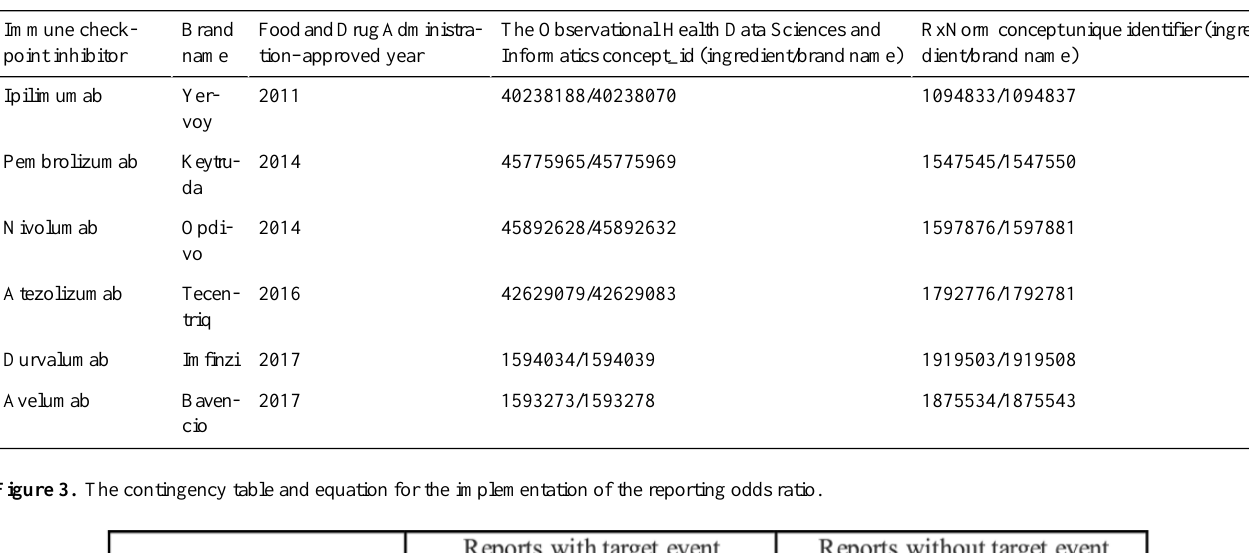
Table 1. The basic information of 6 immune checkpoint inhibitors.